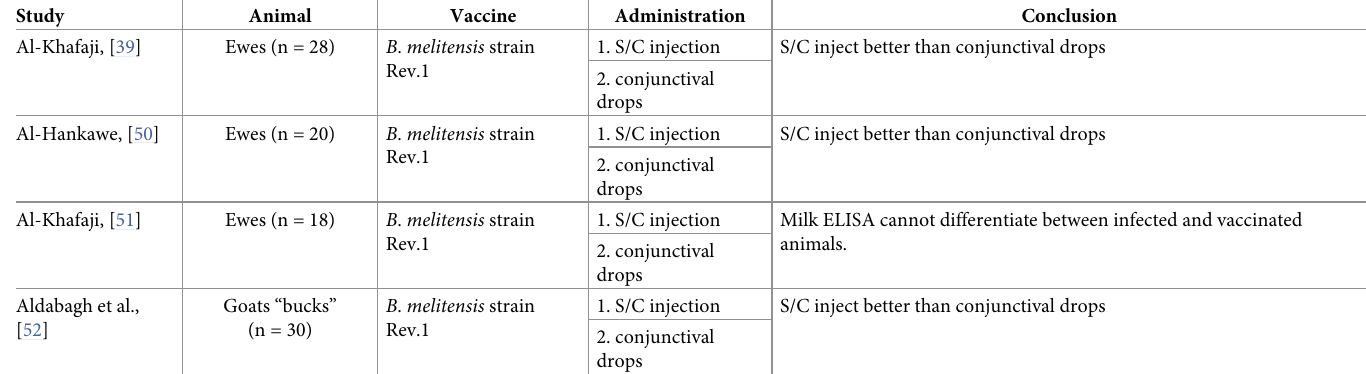
Table 4. Qualified studies that examined brucellosis in different food-producing animals in Mosul, Iraq, with main objective: Assessing vaccines against